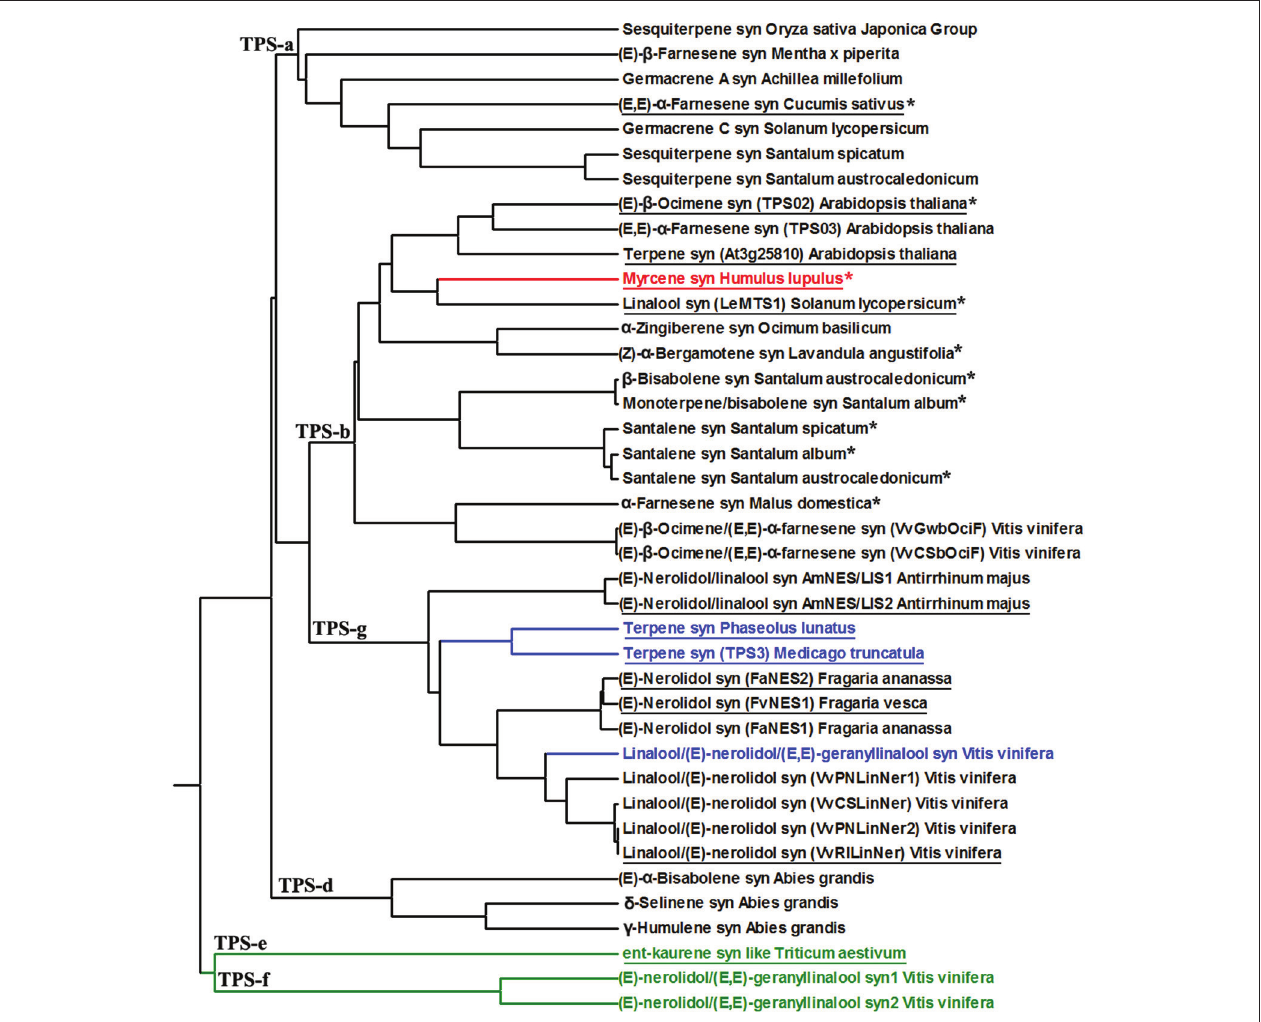
FIGURE 2 | Phylogenetic tree of terpene synthases (TPS) with confirmed capacity for multi-substrate use (Table 1 for details of product and substrate specificities). The red branch denotes TPS with C5/C10 activity, the black branches with C10/C15 activity, the blue branches with C10/C15/C20 activity, and the green branches with C15/C20 activity. These 40 multi-substrate terpene synthase are from different TPS families including TPS-a, TPS-b, TPS-g, TPS-d, TPS-e, and TPS-f. The tree was constructed by MEGA5 software by UPGMA method (Tamura et al., 2011). The asterisks denote the presence of the conserved arginine-rich RRx8W motif at the N-terminal of the protein that is common in many monoterpene synthases (Chen et al., 2011). The underlined enzymes demonstrate the presence of transit